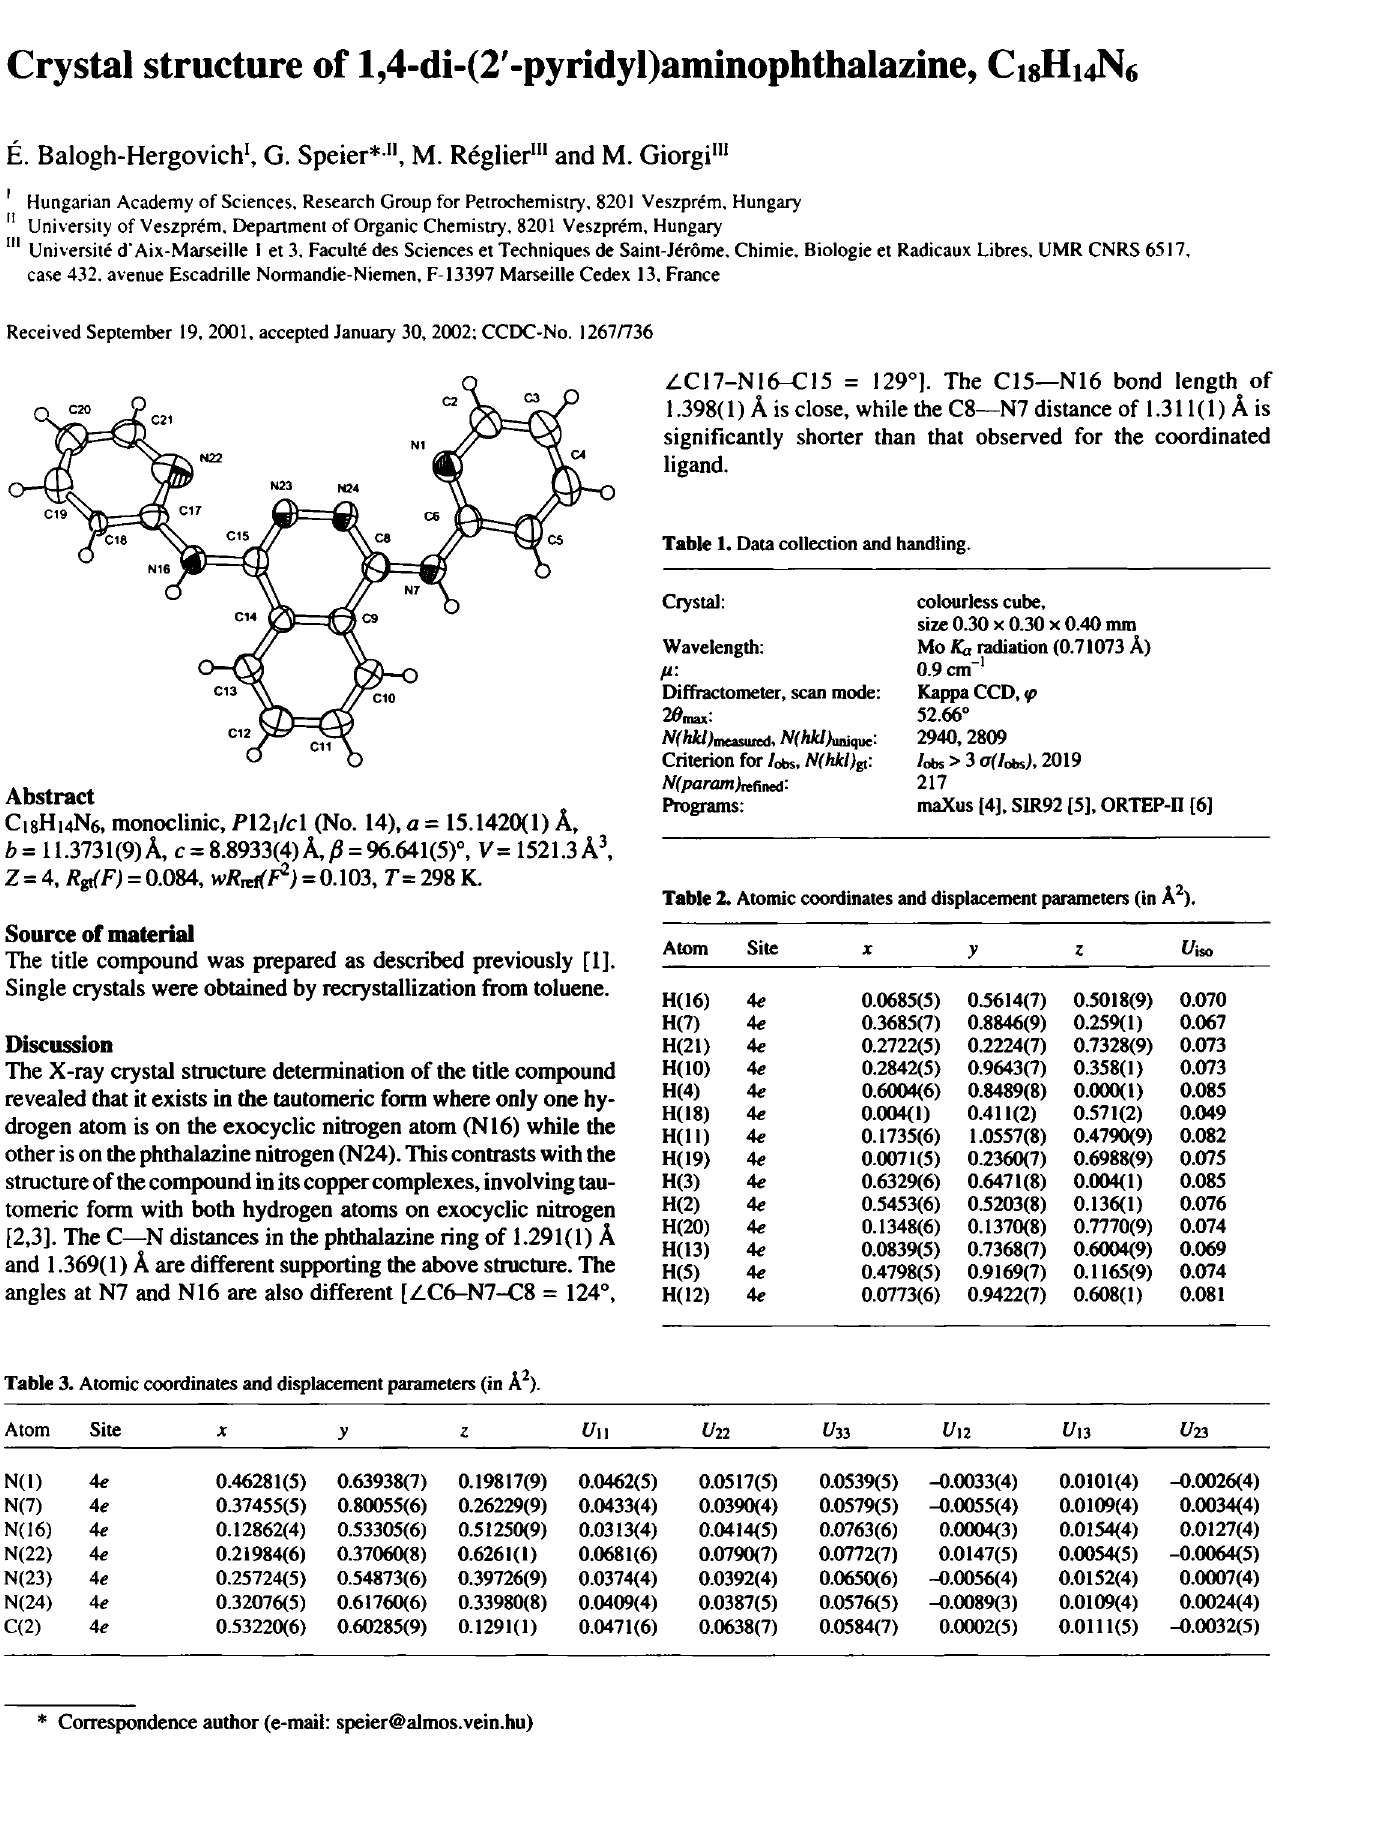
Table 3. Atomic coordinates and displacement parameters (in Â 2